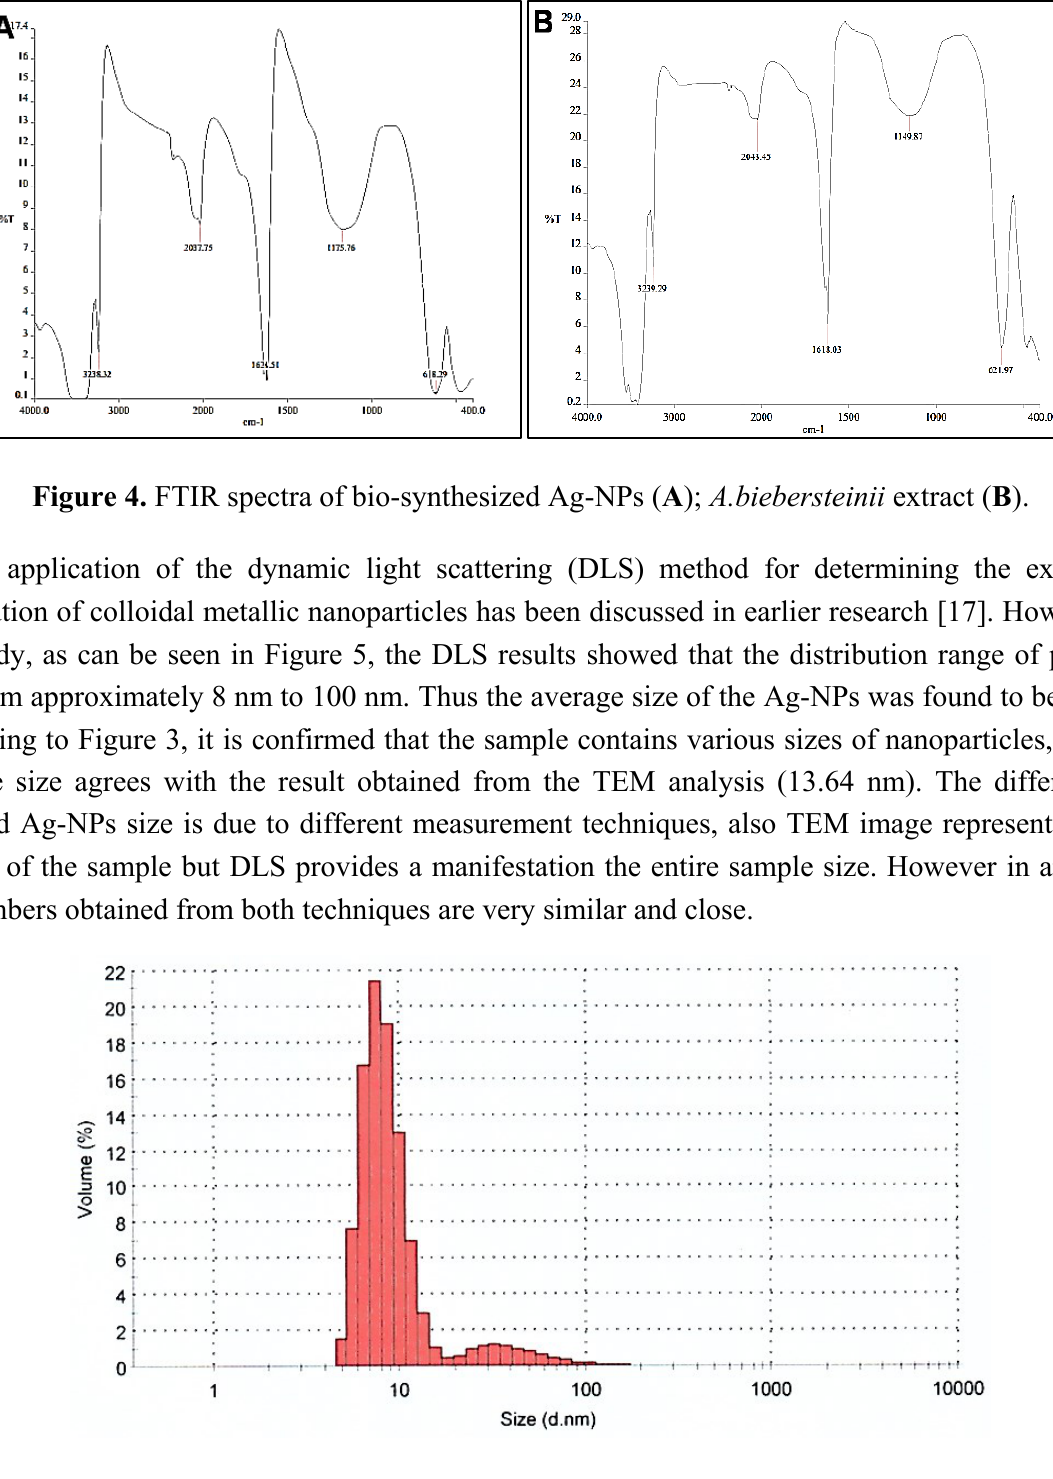
Figure 5. Particle size distribution of biosynthesized